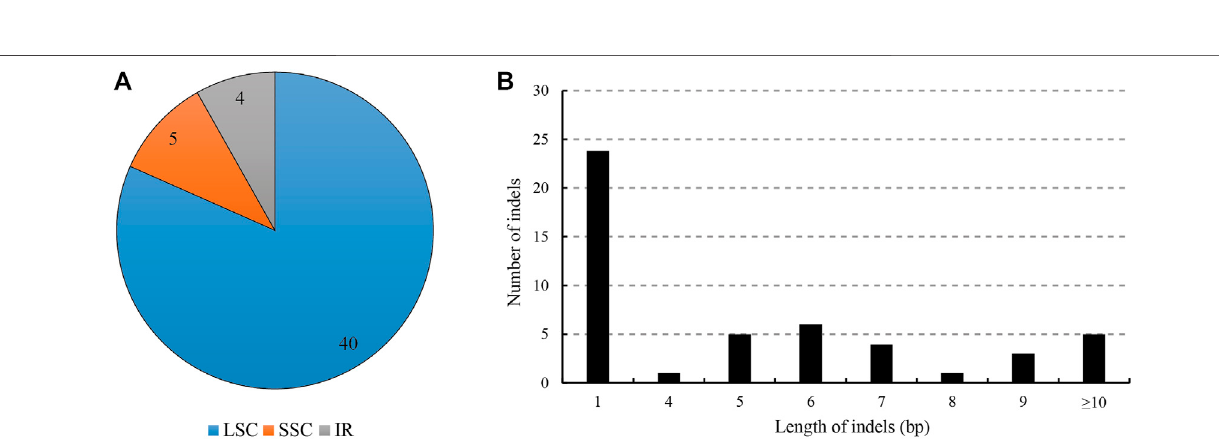
FIGURE3| Analysesofindelsinthe L.cardiaca chloroplastgenomes. (A) Countofindeltypesandlocations. (B) Numberandsizeofindelsinchloroplastgenomes.